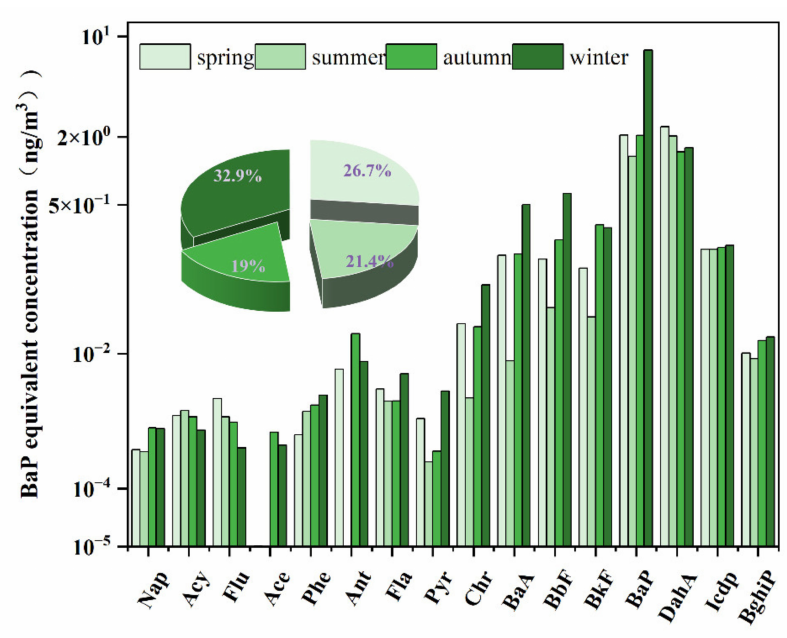
Figure 7. BaP eq concentration from PAH inhalation exposure in four